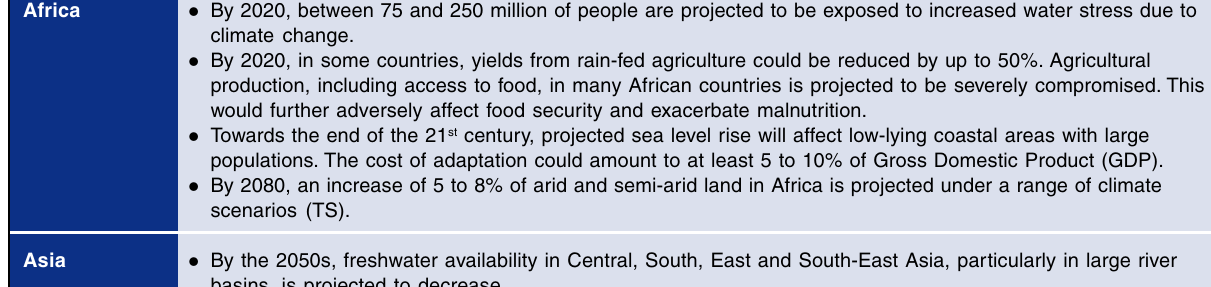
Table SPM.2. Examples of some projected regional impacts. {3.3.2}